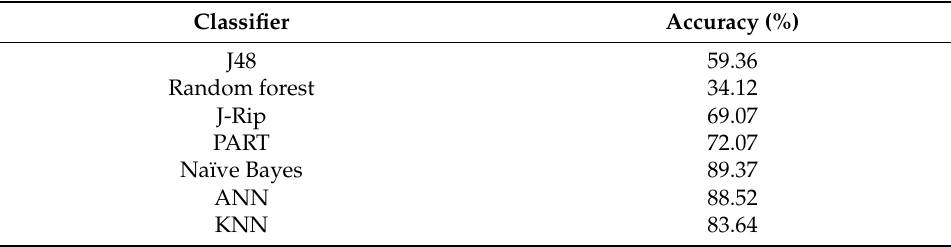
Table 5. The accuracy of seven classifiers in the second classification